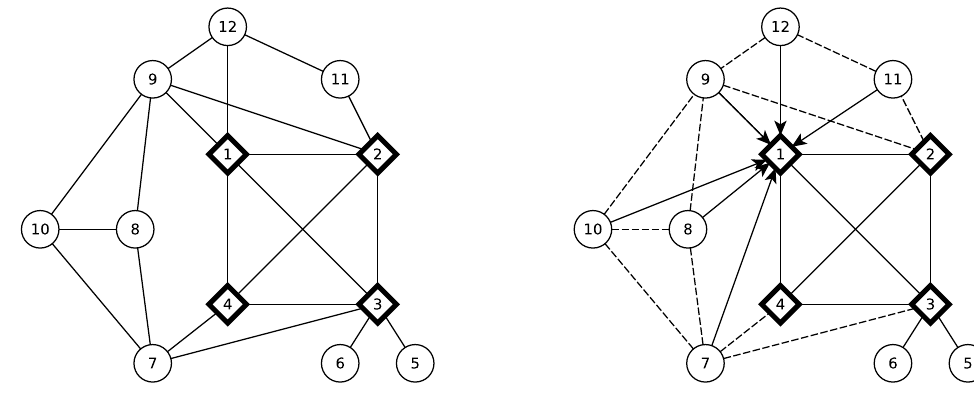
Figure A1. Transforming a network into a generalized star. Protected nodes are depicted in bold. In the left picture, we have V 1 = { 1,7, 8,9,10, 11,12 } , V 3 = { 3,5, 6,7,8, 9,10,11, 12 } , and V 5 = { 5 } . The node 7 is reachable from 4 in G − V 5 . In the right picture, the nodes { 7,8,9,10,11,12 } have degree 1 and are connected to node 1. The node 7 is still reachable from 4 in ˜ G − ˜ V 5